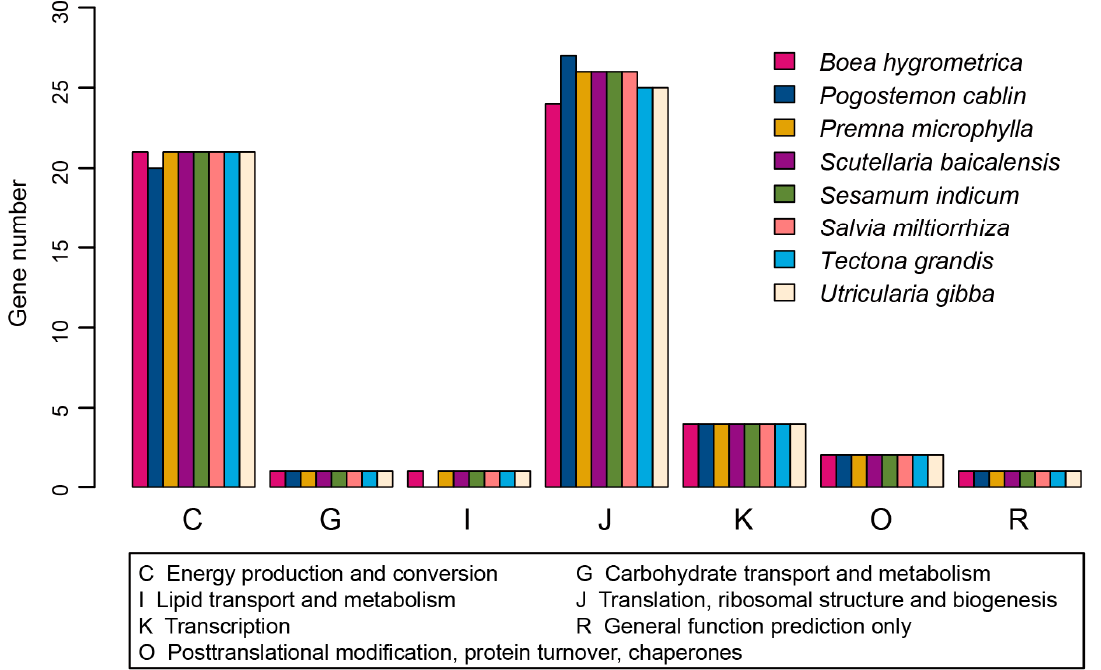
Figure 3. The COG (Clusters of Orthologous Groups) classification and distribution of genes in different species.